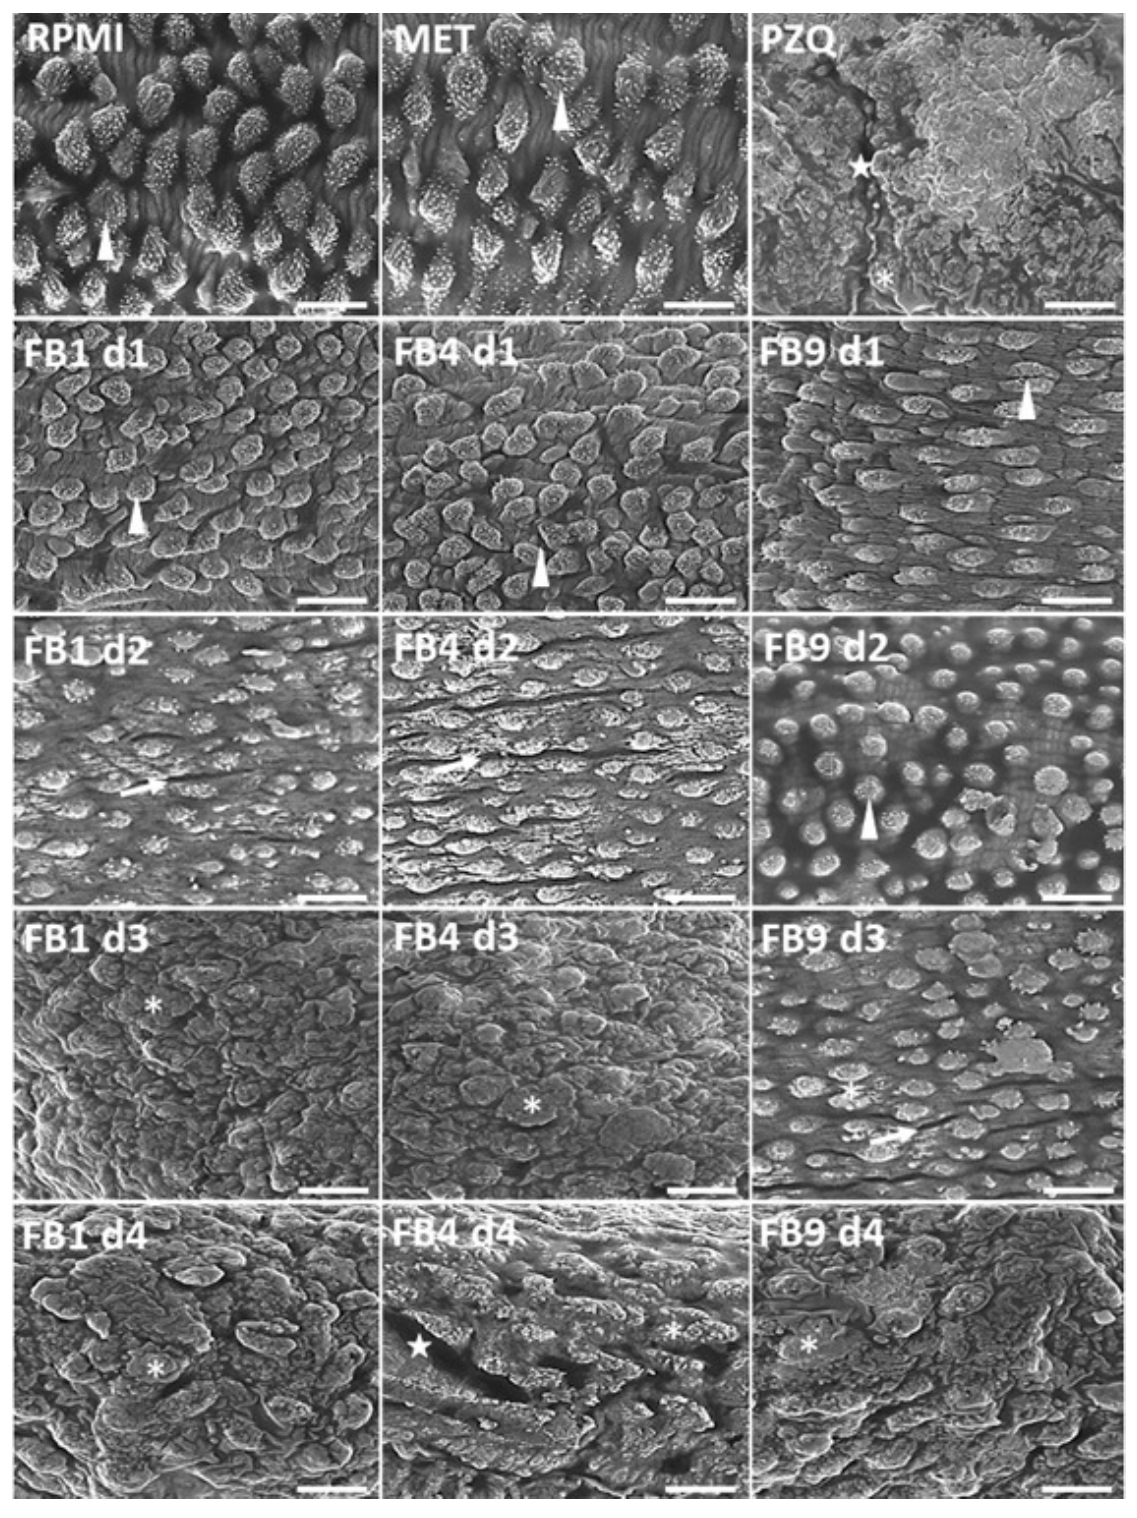
Figure 5. Scanning electronic photomicrographs of the integument of Schistosoma mansoni adult worms untreated and treated with different doses of eugenol derivatives FB1, FB4, and FB9. Controls: RPMI-1640 supplemented medium, RPMI-1640 medium plus 25.0 µL of methanol – MET (the vehicle used as solvent for the samples) and with PZQ (0.0064 mM pharmacological control). Representative images from the end of a 192-hour observation period. RPMI-1640 and MET: integument with preserved morphology, showing prominent tubercles and well-defined spicules and PZQ: tubercle collapse, spicule disappearance and integumentary contraction bands. Arrowhead: tubercles with spikes. Arrow: contraction bands. Asterisk: collapsing tubercles in degeneration. Star: erosion of the integument. FB1 and FB4, complete loss of the integument grooves at dose 3 (d3). *d1 and d2: doses below ED50 to FB1, 0.104 and 0.208 mM; FB4, 0.080 and 0.161 mM; FB9, 0.203 and 0.270 mM. *d3 and d4: doses above ED50 to FB1, 0.416 and 0.521 mM; FB4, 0.242 and 0.322 mM; FB9, 0.405 and 0.473